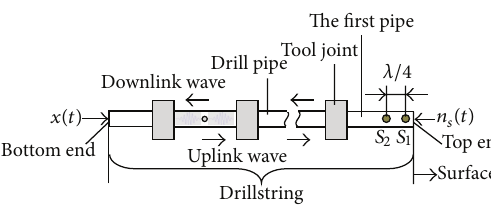
Figure 2: Schematic diagram of the proposed model.